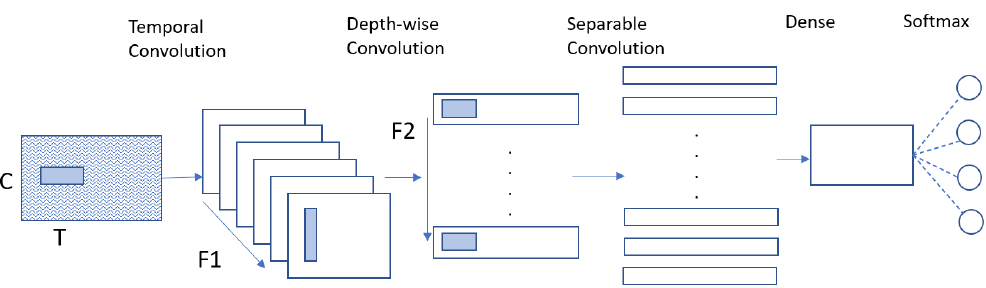
Figure 3. Architecture of the EEGNet model.